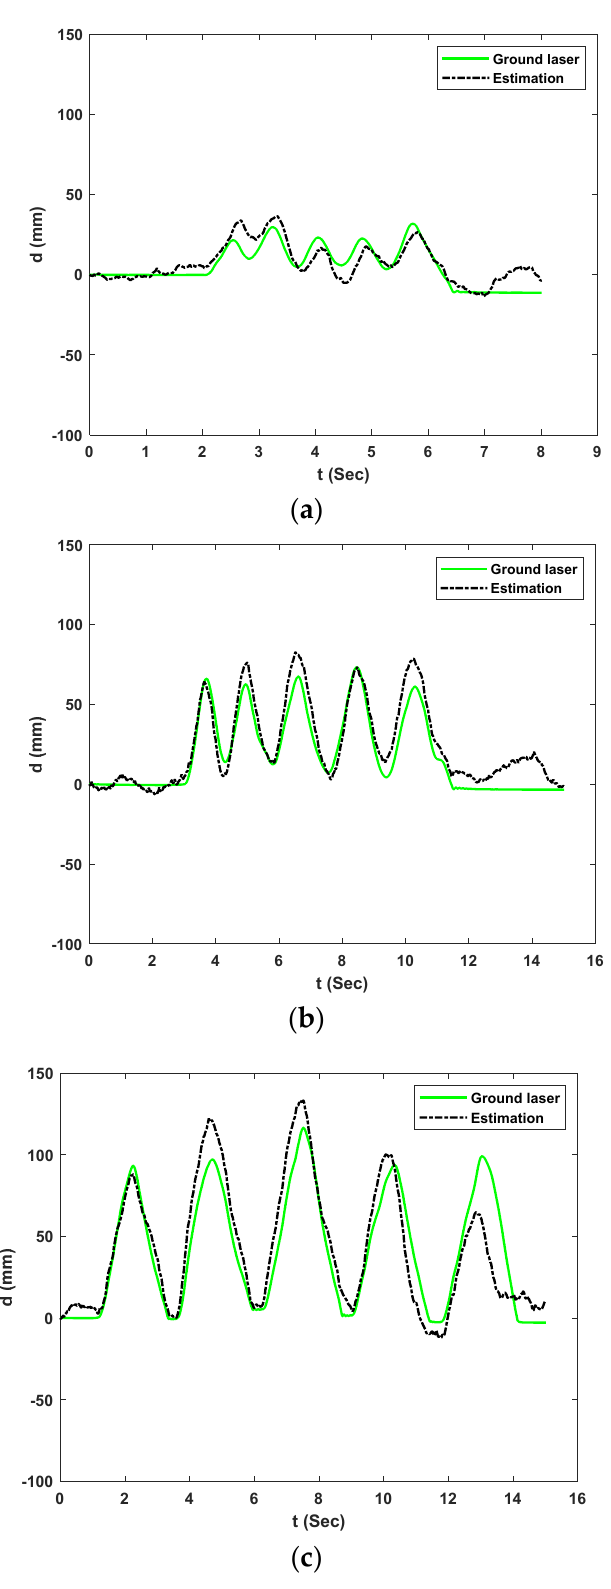
Figure 12. UAS measurement versus the ground laser of the moving board for experiment 2: ( a ) Fourth car displacement estimation; ( b ) Second car displacement estimation; ( c ) Third car displacement estimation.